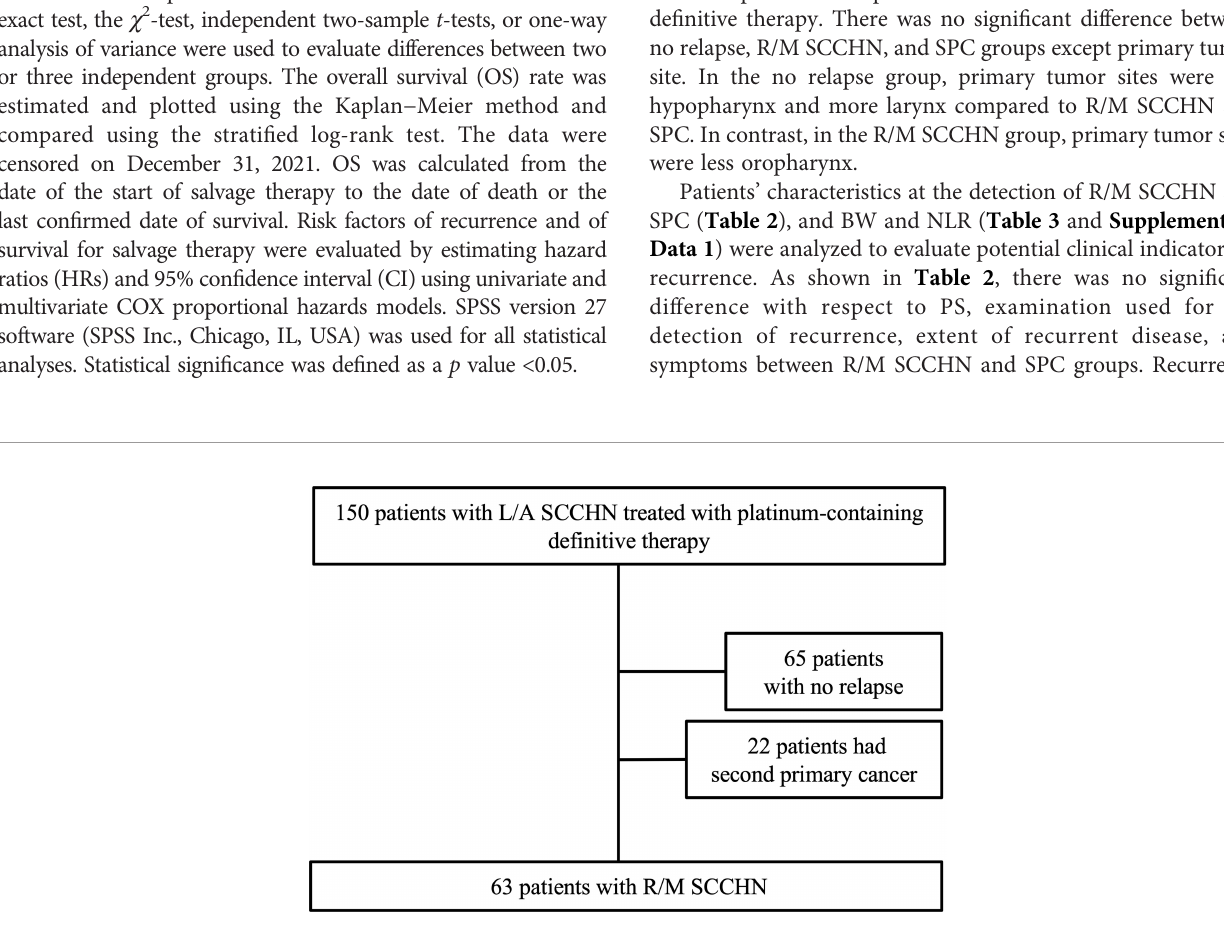
FIGURE 1 | Diagram showing the process of patient selection. L/A SCCHN, local advanced squamous cell carcinoma of head and neck; R/M, recurrent and/or